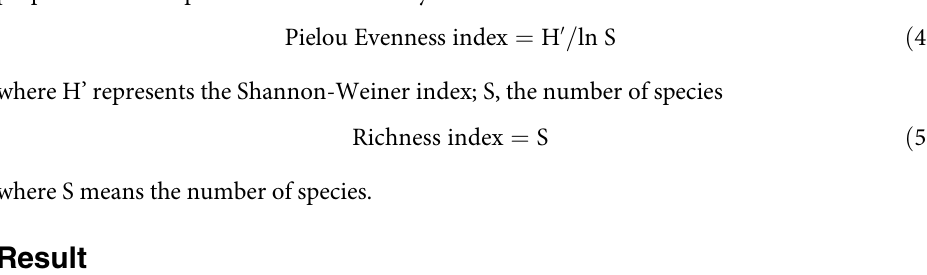
Table 2. Vegetation characteristics of different type grasslands.